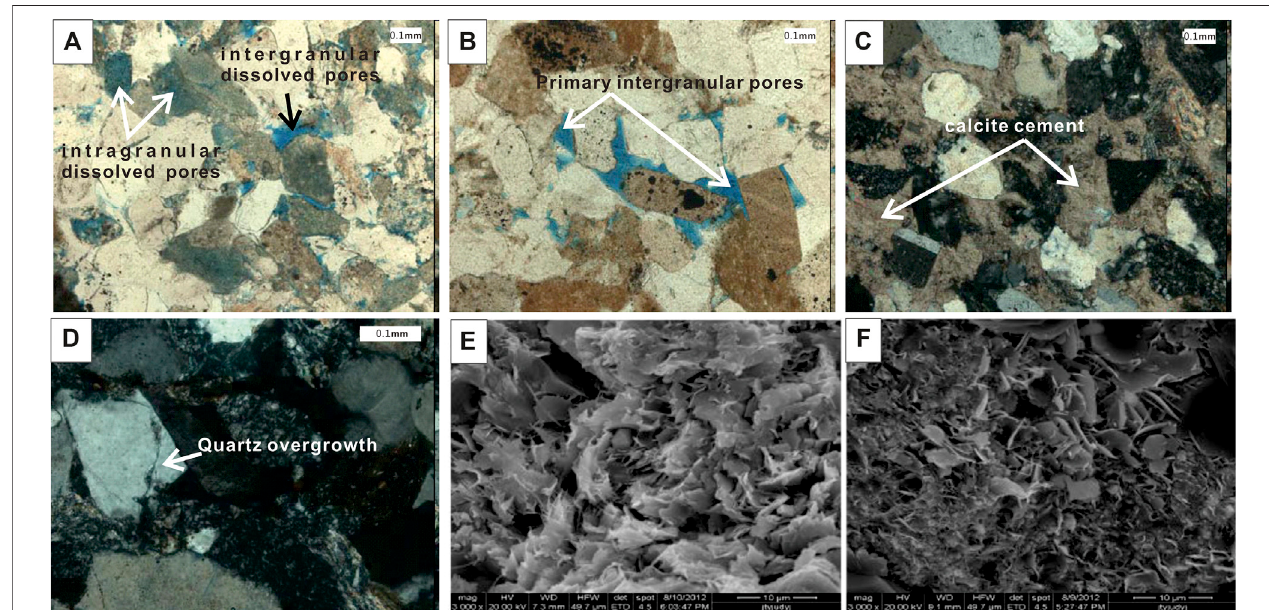
FIGURE3| MicrophotographsofKepingtageFormationreservoirrocks (A) Intergranulardissolvedporesandintragranulardissolvedpores, fi netomediumgrained litharenite, Well Sh904H, 5576.58m, 10 × 10, (-) (B) Residual primary intergranular pores and intergranular dissolved pores, fi ne-medium grained quartz litharenite, Well Sh901, 5503.62m, 10 × 10, (-) (C) Intergrowth calcite cement, fi ne to medium grained litharenite, Well Sh904H, 5584.40m, 10 × 10, (+) (D) Quartz overgrowth, fi ne to medium grained litharenite, Well Sh904H, 5511.08m, 10 × 20, (+) (E) Particle surface with fi lamentous and laminated illite-smectite mixed layer, fi ne-medium grainedquartzlitharenite,WellSh904H,5367.66m,SEM,300 × . (F) Particlesurfacewithlaminatedchlorite, fi netomediumgrainedlitharenite,WellSX2,5678.26m,SEM 3000 × .